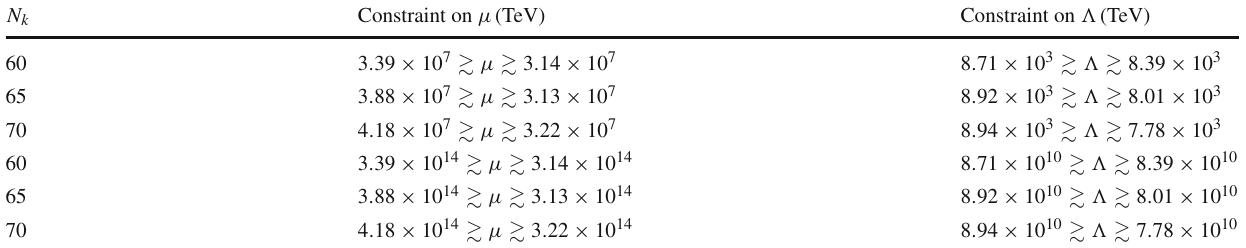
Table 9 Results for the constraints on the mass scales μ and (cid:5) for Higgs-like inflation in the high-energy limit of the Randall–Sundrum brane model using the last data of PLANCK. The top table shows the